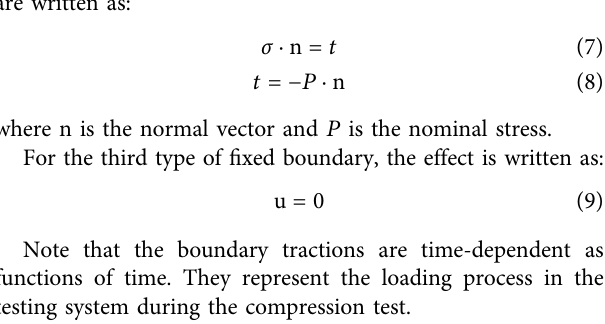
Frontiers in Earth Science |